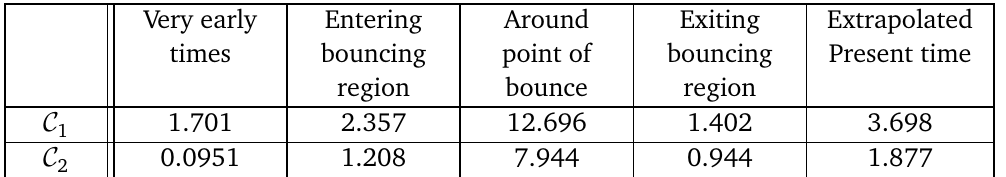
Figure 31: Logarithm of linearly weighted complexity in different regions against scale factor. Table 5: Complexity values at different points of interest with respect to scale